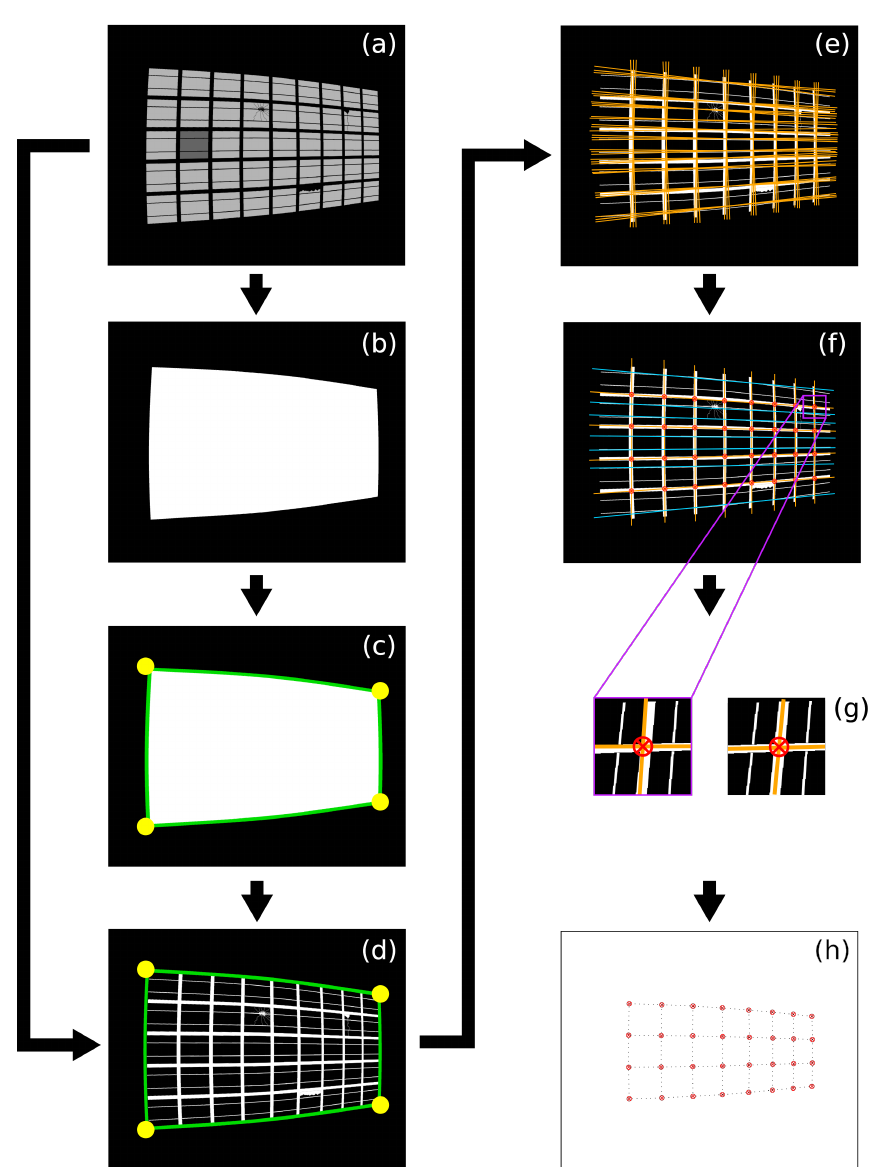
Figure 2. Pattern Detection Process: ( a ) Distorted input EL image. ( b ) Binarization of the EL image and morphological filters to highlight active cell area as one object. ( c ) Contour and corner detection. The active cell area contour is the region of interest (ROI) for the pattern detection process. The corners are used for perspective transformation and for cropping the active cell area. ( d ) Binarization of the EL image and morphological filters to highlight dark structures in the ROI. ( e ) Hough line search algorithm detects multiple lines for each cell gap and busbar structure. ( f ) Line validation and classification. Determining of the line that fits the best for a curved cell gap or busbar structure. Line classification to differentiate between busbars and cell gaps. Intersection points of cell gap lines are used to define small ROI windows around the intersection points. ( g ) Additional iteration steps (from ( e ) to ( f )). Precise Hough line search in ROI windows because the straight lines do not match exactly on the curved cell gaps. ( h ) Final cell gap joint pattern for camera parameter estimation in Figure